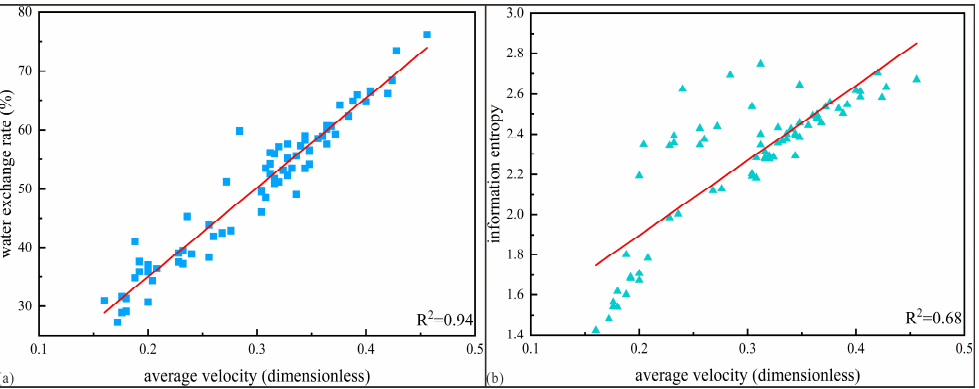
Figure 13. Fitting diagram of three parameters: ( a ) water exchange rate and average velocity; ( b ) information entropy and average